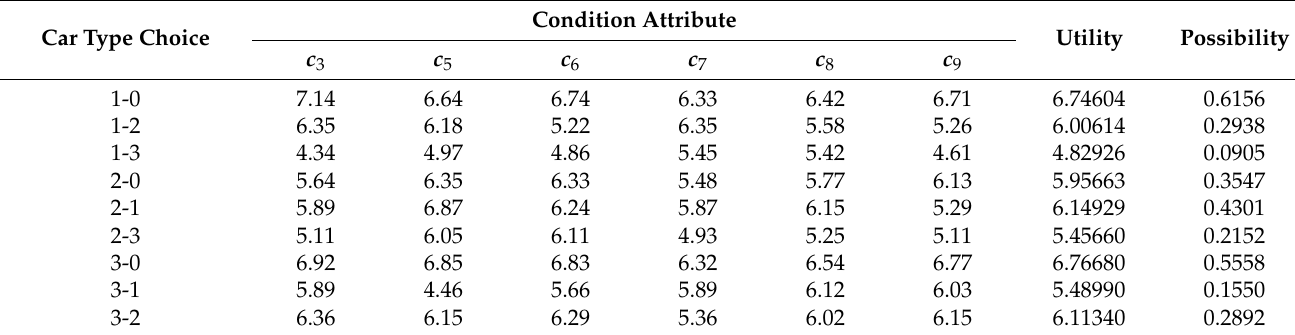
Table 5. Influencing factor scores, utilities, and possibilities.